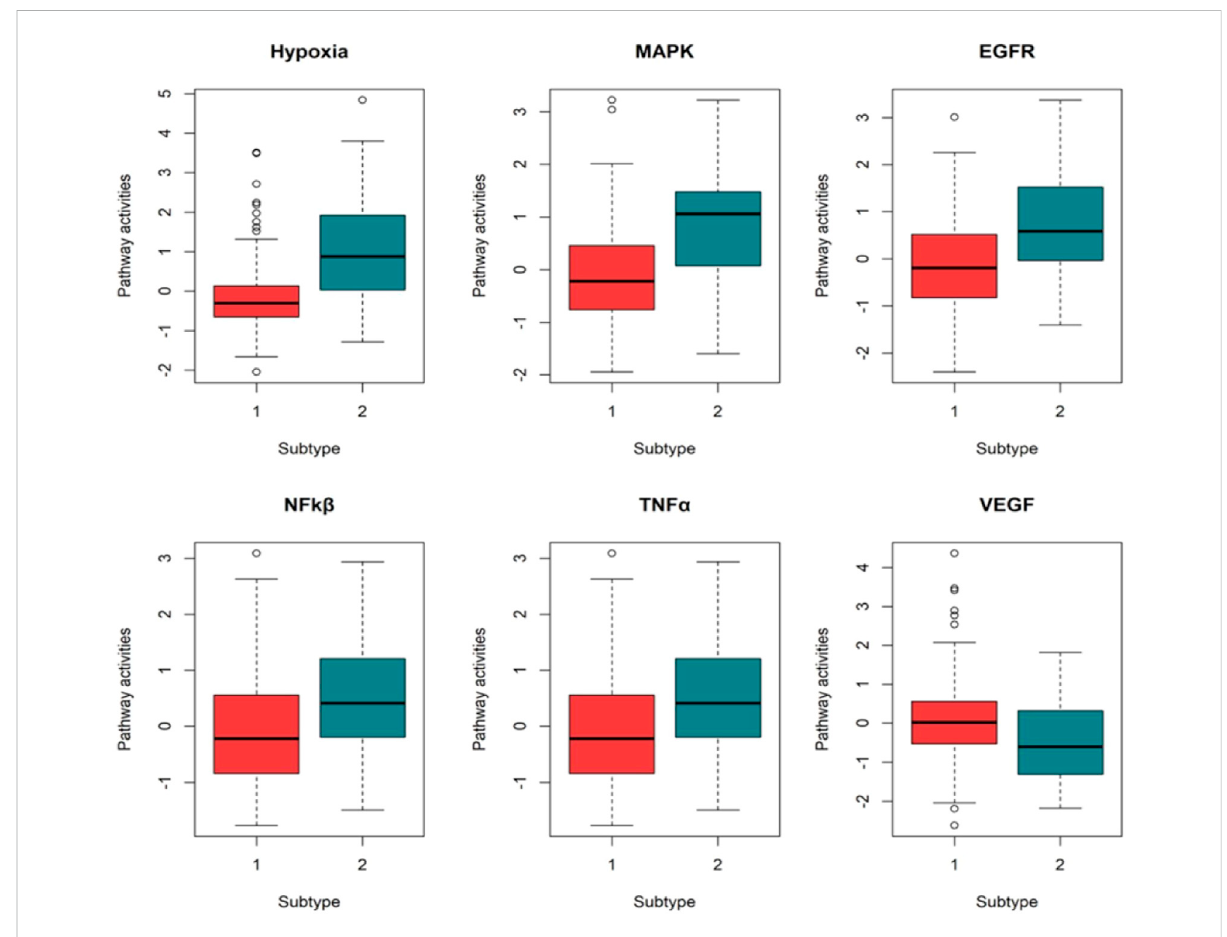
FIGURE 5 Boxplots showing the pathway activity for six pathways.